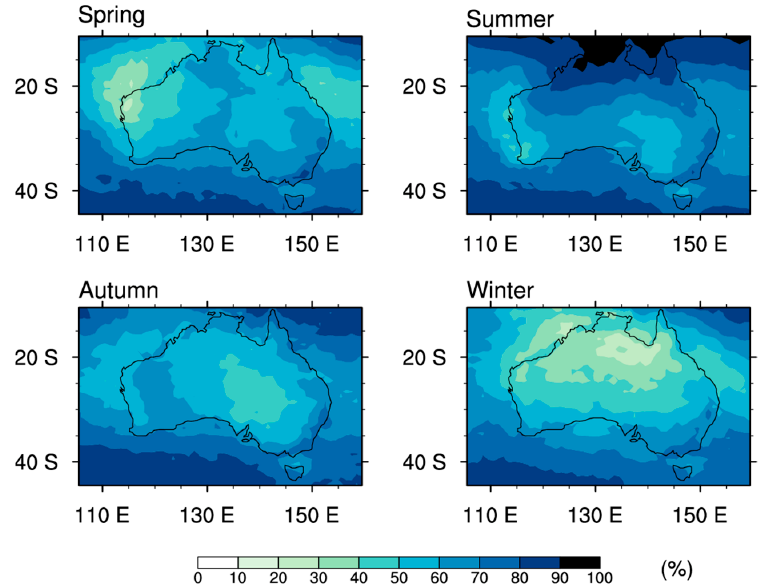
Figure 2. Total cloud observation percentage images, seasonally averaged over 17 years of HIRS data (1985–2001) for the Australian region (10 ◦ S–45 ◦ S, 105 ◦ E–160 ◦ E). Images separated into Southern Hemisphere spring months ( top left ), summer months ( top right ), autumn months ( bottom left ) and winter months ( bottom right ). Analysing an extended period of HIRS data allows for a comparison between two 224 separate time periods where any systematic trends in cloud frequency might be high- 225 lighted. For the 17 years between 1985 and 2001, an initial eight-year period consists of 226 averaged HIRS cloud frequency data between the years of 1985 and 1992. A second eight- 227 year period averages HIRS cloud frequency data between 1994 and 2001. Figure 3 illus- 228 trates the differences in HIRS total cloud frequency between these two periods by sub- 229 tracting the averaged data for 1985 to 1992 from the more recently averaged data for the 230 period 1994 to 2001. An overlaid reference of state boundaries and regional locations across Australia are also included in Figure 3.